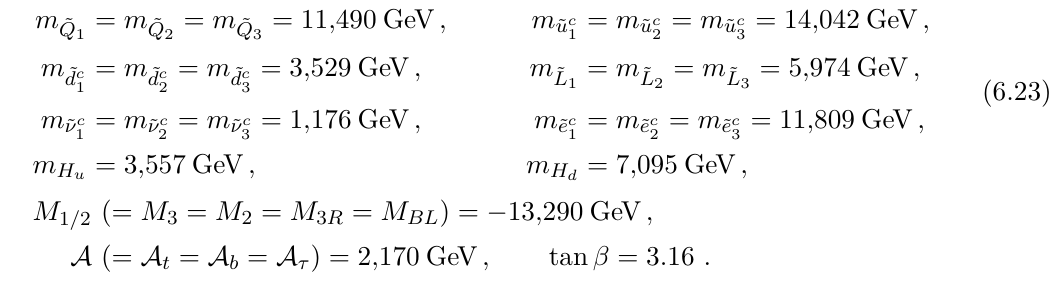
Figure 3 : Plot of the “black” points obtained after running the RGE simulation at the point ( a 1 , a 2 , a 3 ) = (0 . 910 , 1 . 401 , 0 . 163) . We statistically throw 10 million sets of random initial data. The 3,330 “black” points we obtain are further divided into two sets by color. With red we display the acceptable “black” points” that, in addition, have the correct b value at the unification scale (eq. (6.22)). The remaining 2,974 unacceptable “black” points that do not satisfy this constraint are shown in black. Two points are circled in this plot. The point circled in red is an acceptable “black” point which has the initial data given in (6.16). The point circled in black is an unacceptable “black” point which has the initial data shown in